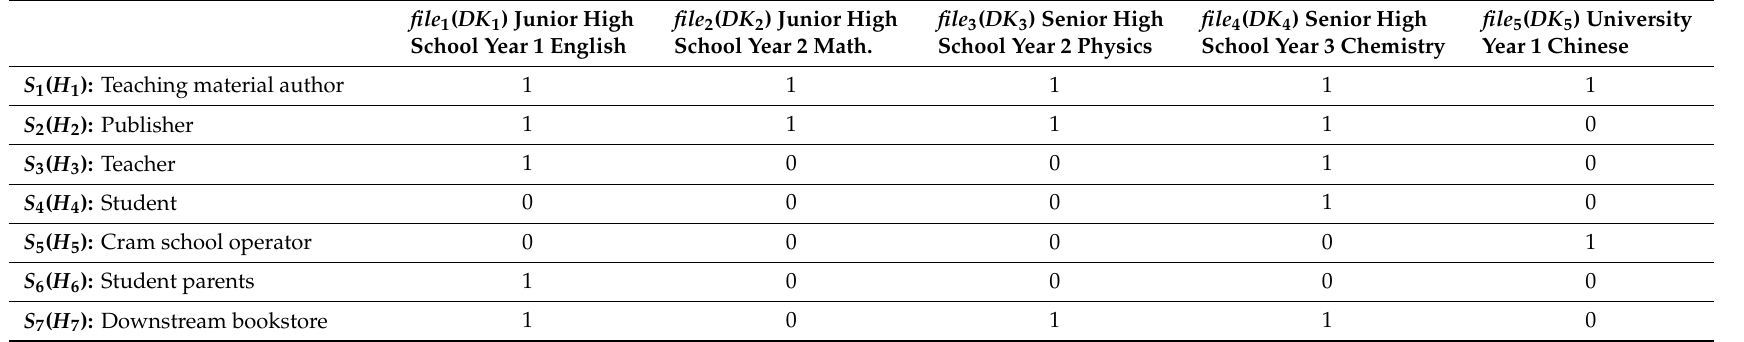
Table 4. The results after adding a new security